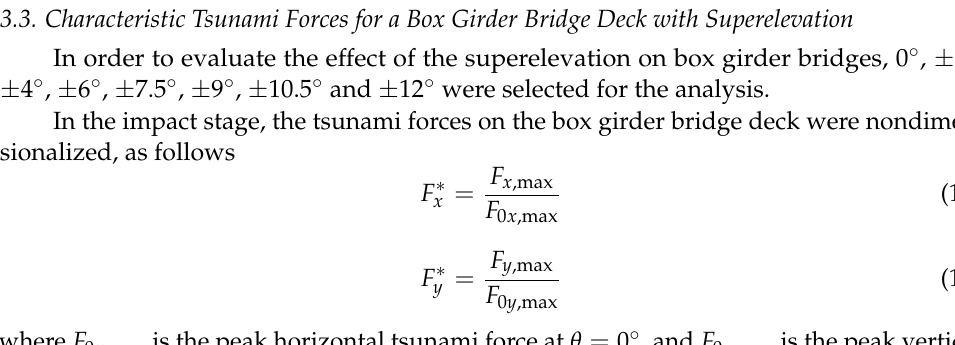
Figure 15. Normalized maximum tsunami forces at di ff erent relative wave heights: ( a ) horizontal tsu- nami force; ( b ) vertical tsunami force ( h 1 = 0.6 m). tsunami force; ( b ) vertical tsunami force ( h 1 = 0.6